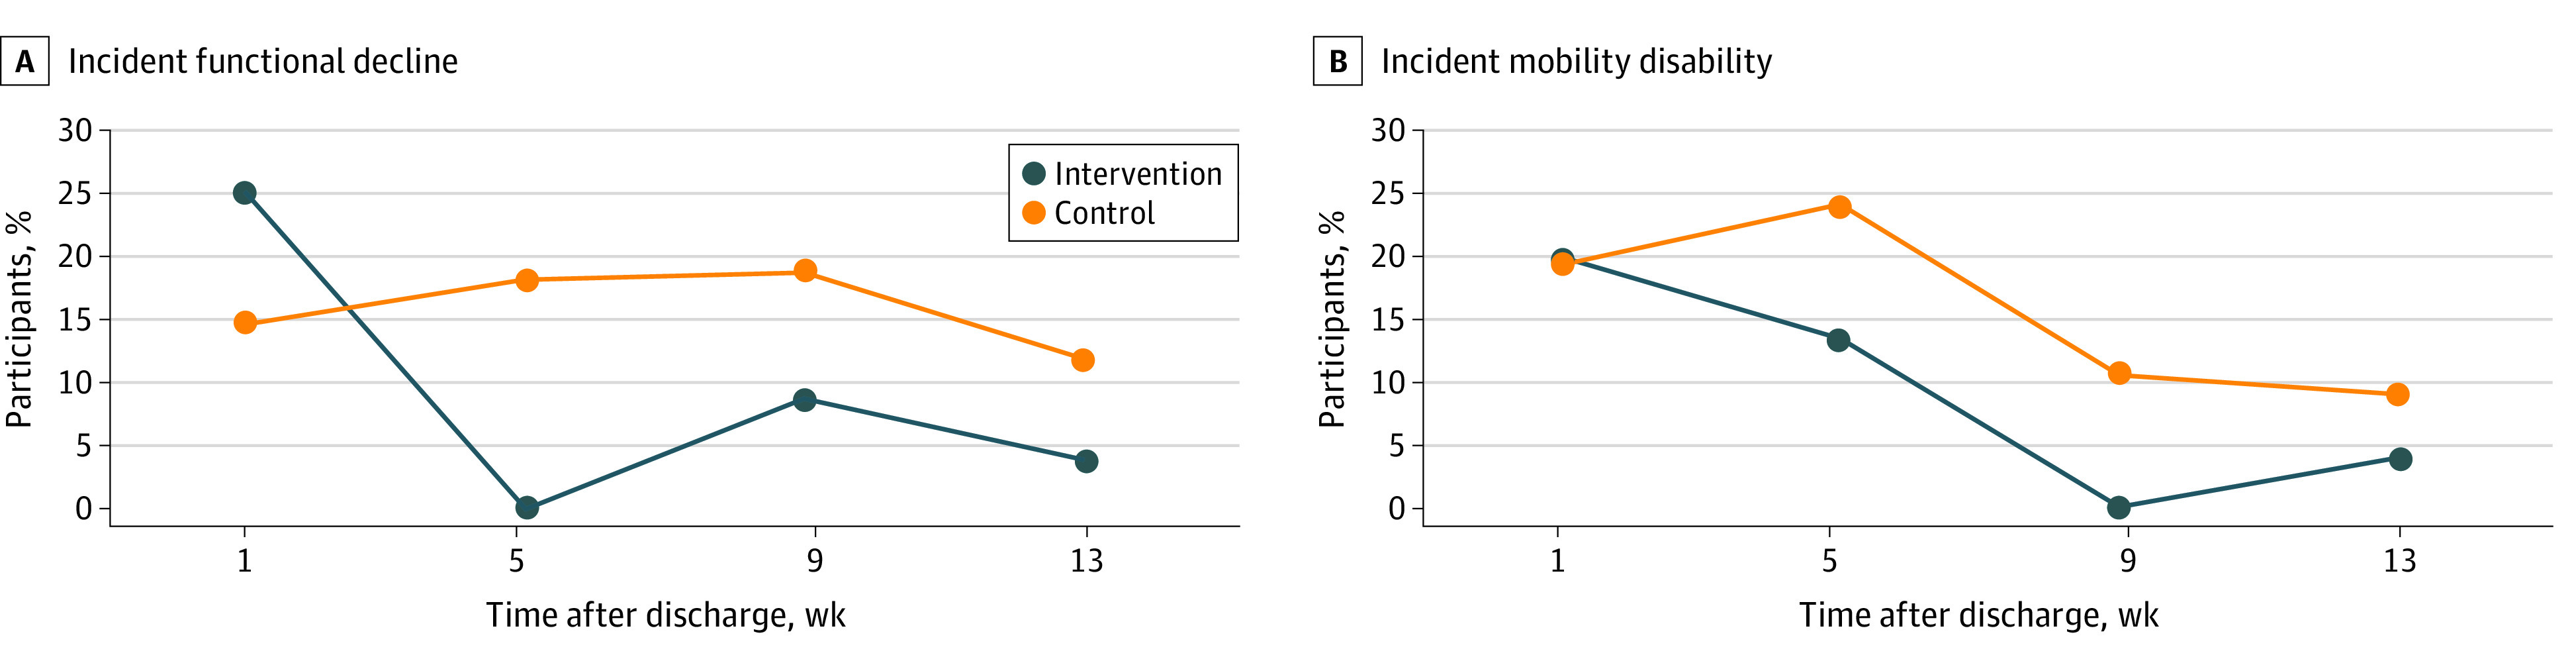
Incident Functional Decline and Mobility Disability in Subgroup AnalysisPanel A depicts new functional disability (increased difficulty with activities of daily living from baseline), and panel B depicts new mobility disability (increased difficulty walking a quarter mile) by study group beginning 1 week after discharge and ending after 12 subsequent weeks for the intervention.